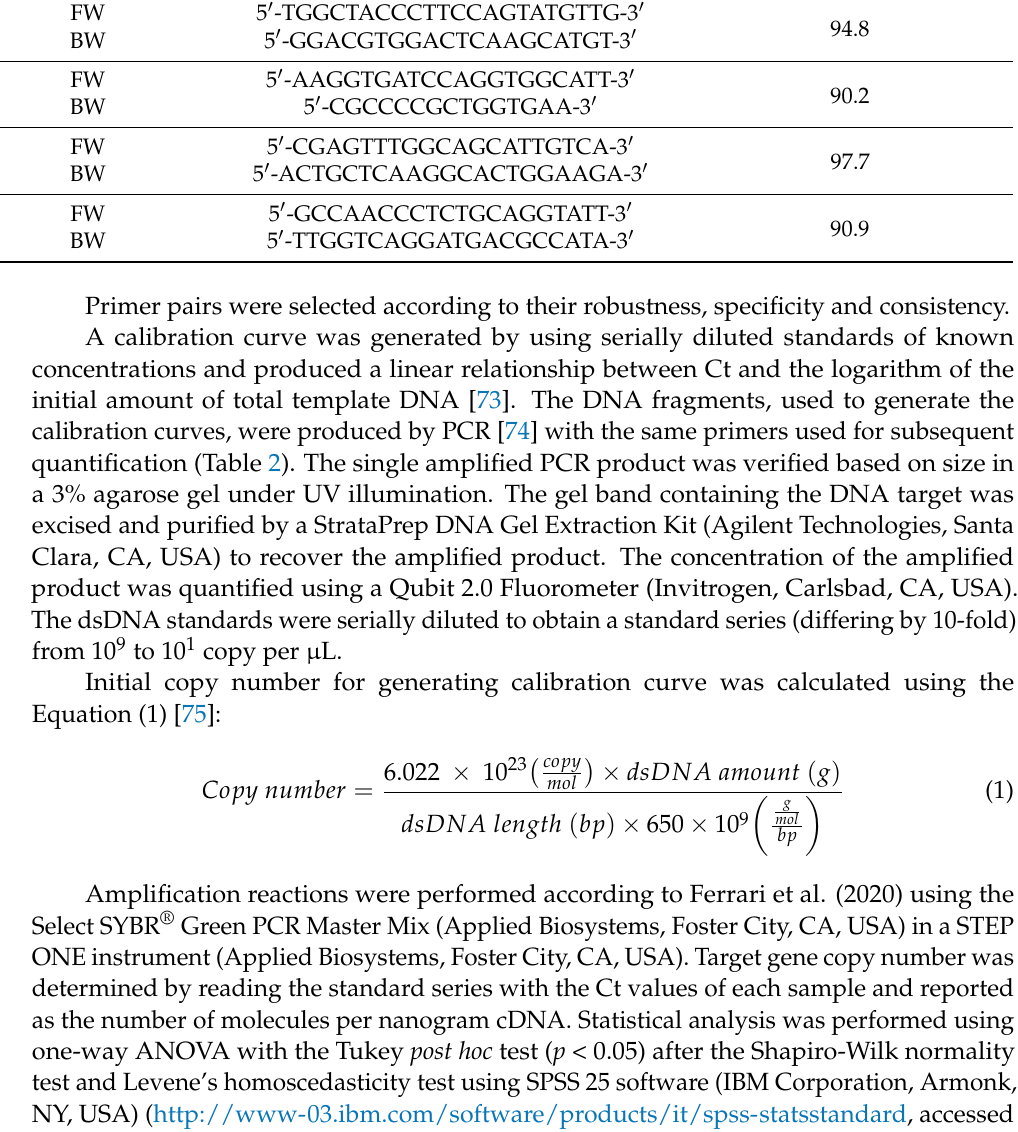
Figure S5: Alignment between SaSabc and C. reinhardtii Sabc amino acid sequences: conserved motifs; Figure S6: Alignment between SaSBP and C. reinhardtii SBP amino acid sequences: conserved motifs; Figure S7: Weblogo of SBP and CysA amino acid sequences. Table S1: Sequence used to phylogenetic